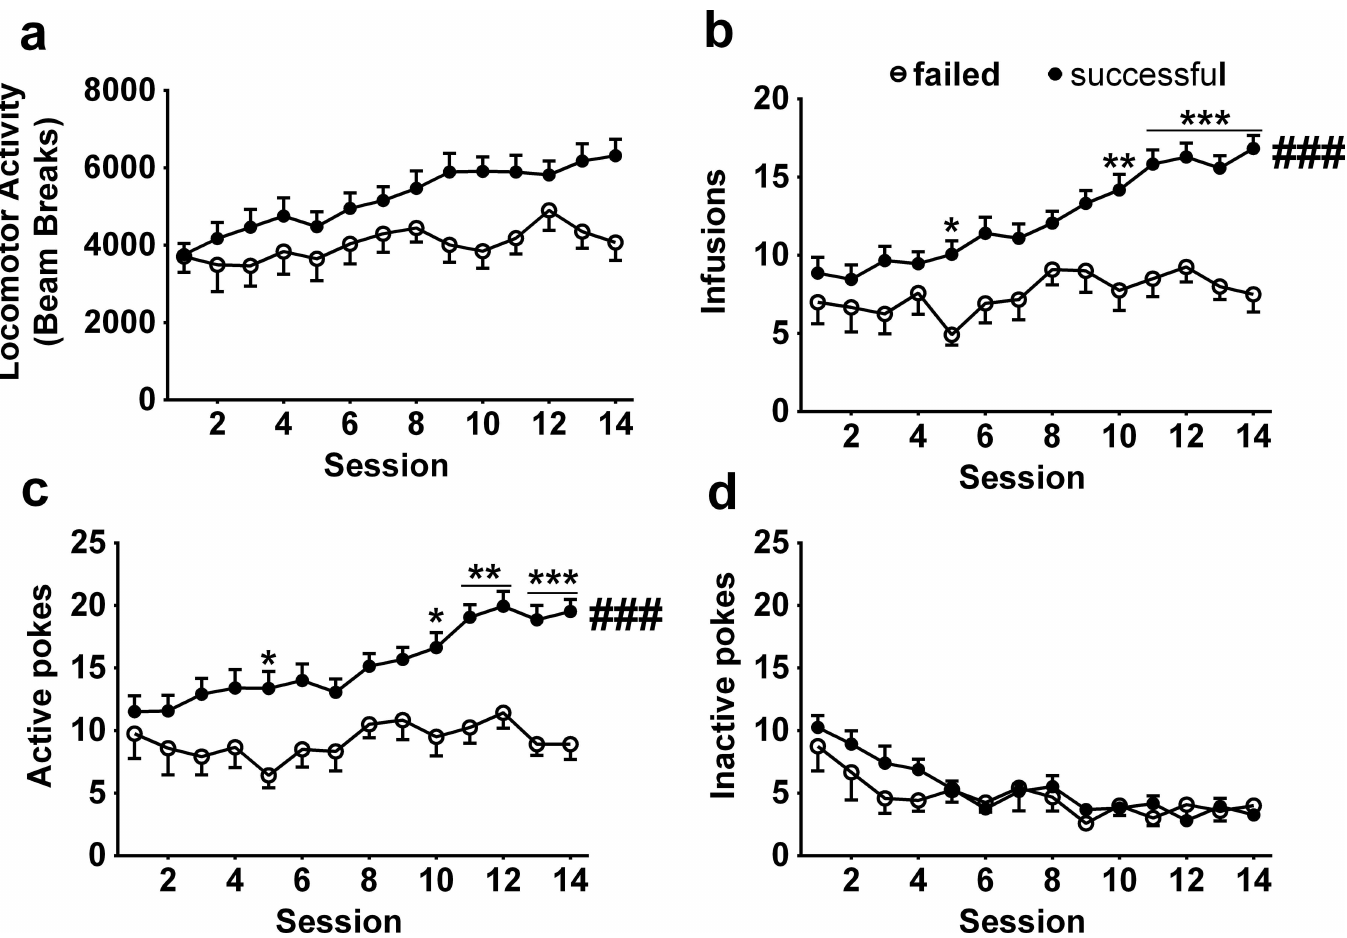
Fig 2. Locomotor activity in successful or failed acquisition of morphine SA. (a) The locomotoractivity in the successful acquisitiongroup was higher than in the failed acquisitiongroup. (b) The morphine infusionsin the successful acquisitiongroup were higherthan failed acquisitiongroup. (c) The active pokes in the successful acquisitiongroup were higherthan failedacquisitiongroup. (d) The inactive pokes had no significantdifference betweenthe successful acquisitiongroup and failed acquisitiongroup. ### p < 0.001, comparedto failed acquisitiongroup. * p < 0.05, ** p < 0.01, *** p < 0.001, post hoc test comparedto failed acquisitiongroup on the same session. Successful acquisitiongroup, n = 35; failedacquisitiongroup, n = 12.